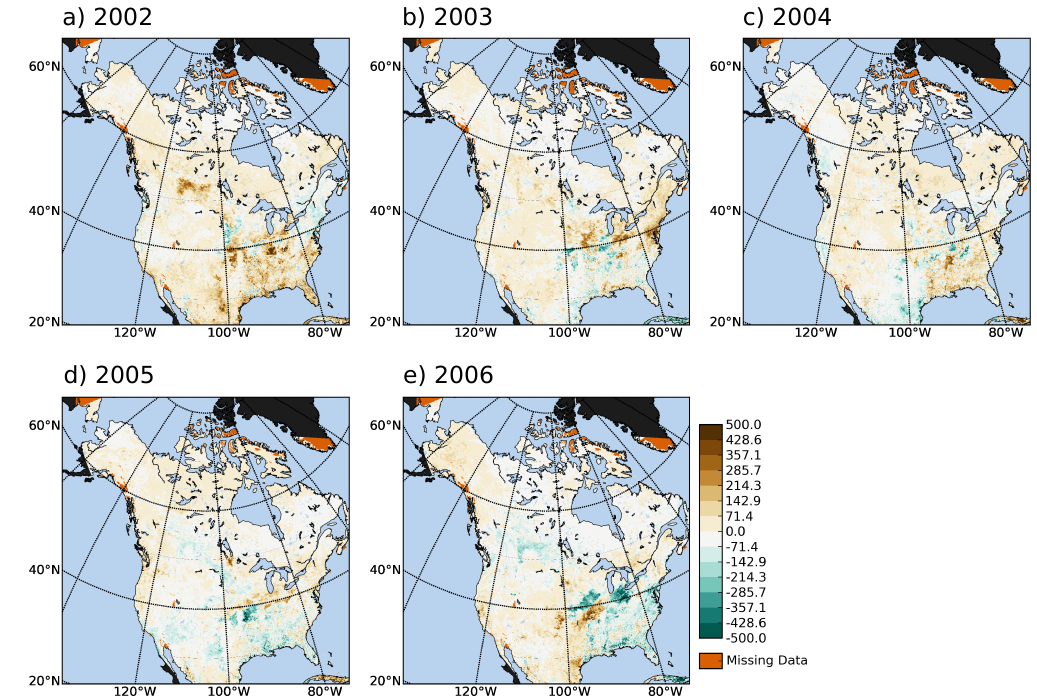
Fig. 12. Annual anomaly, annual integrated VPRM NEE, calculated using PFT–all-data VPRM parameters. Units are gCm − 2 yr − 1 . Anoma- lies are calculated as annual integrated VPRM NEE minus the 2002–2006 mean annual integrated VPRM NEE. Thus negative values denote greater than average atmosphere to ecosystem CO 2 flux. Black areas are outside of the study